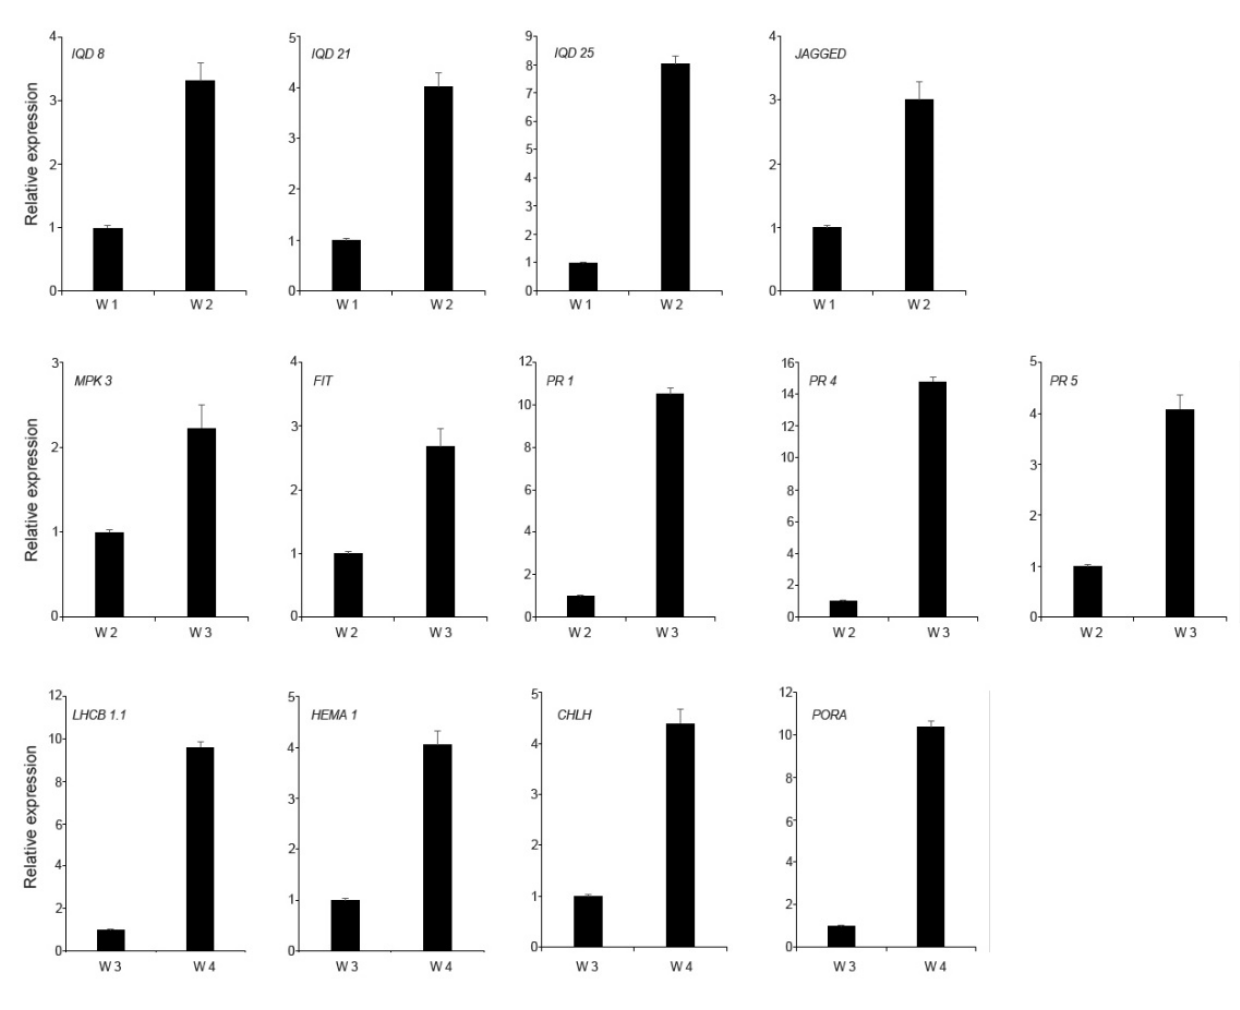
Figure 4 Validation of RNA sequencing results by real-time quantitative PCR. Relative expression of various genes determined by qRT-PCR in the NO wild type during different developmental stages. Relative expression was normalized to UBQ1 levels. Bars indicate the SD of three biological